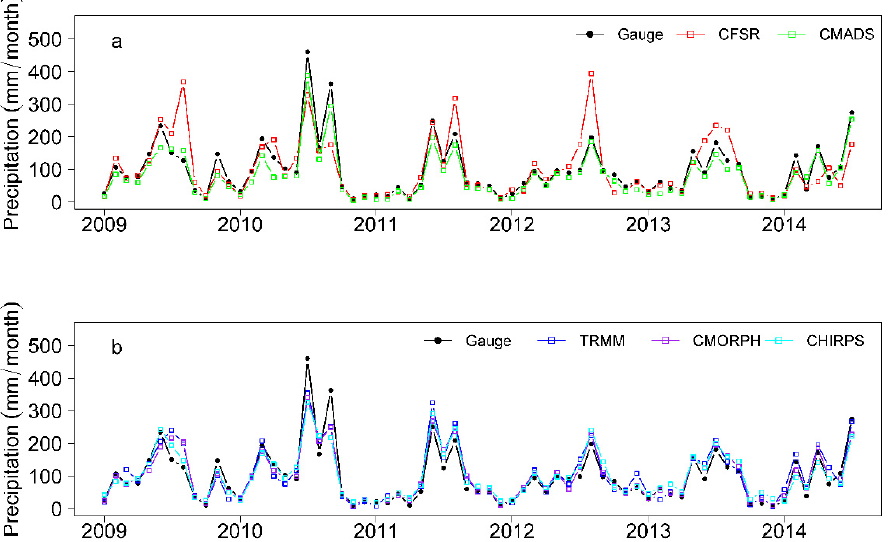
Figure 4. Comparison of monthly precipitation totals from six datasets at the watershed scale during 2009–2014, including ( a ) Gauge CFSR, and CMADS, ( b ) Gauge, TRMM, CMORPH, and CHIRPS.